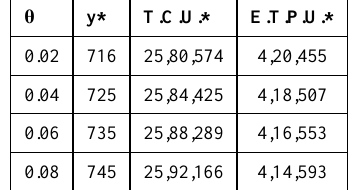
Table 1. Impact of x on optimal production policy